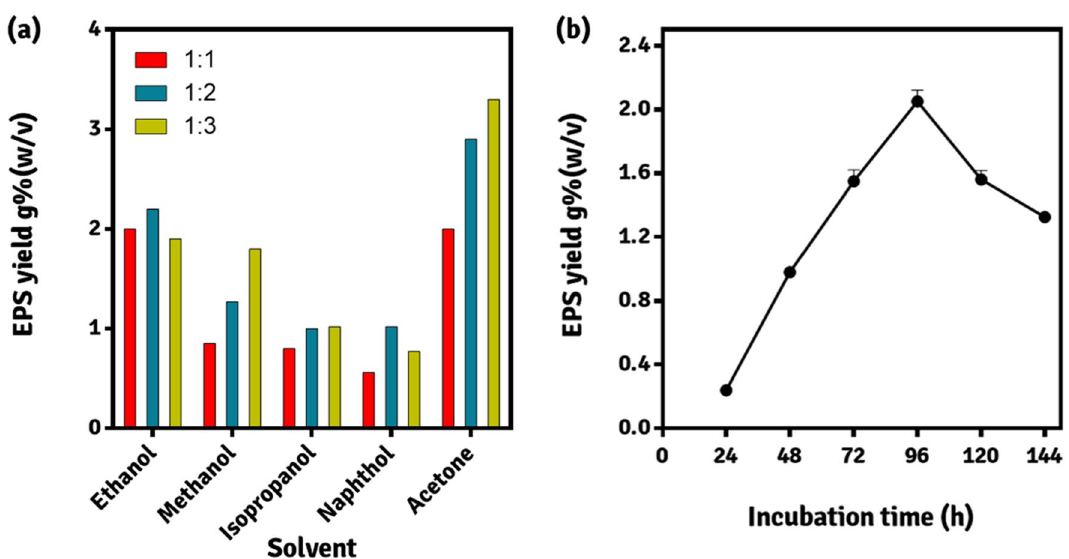
Figure 6. EPS study ( a ) efficiency of extraction solvent for recovery of EPS. 1:1, 1:2 and 1:3 indicate the ratio (v/v) of EPS broth to the solvent used ( b ) effect of incubation time on EPS production. (Image created in GraphPad Prism